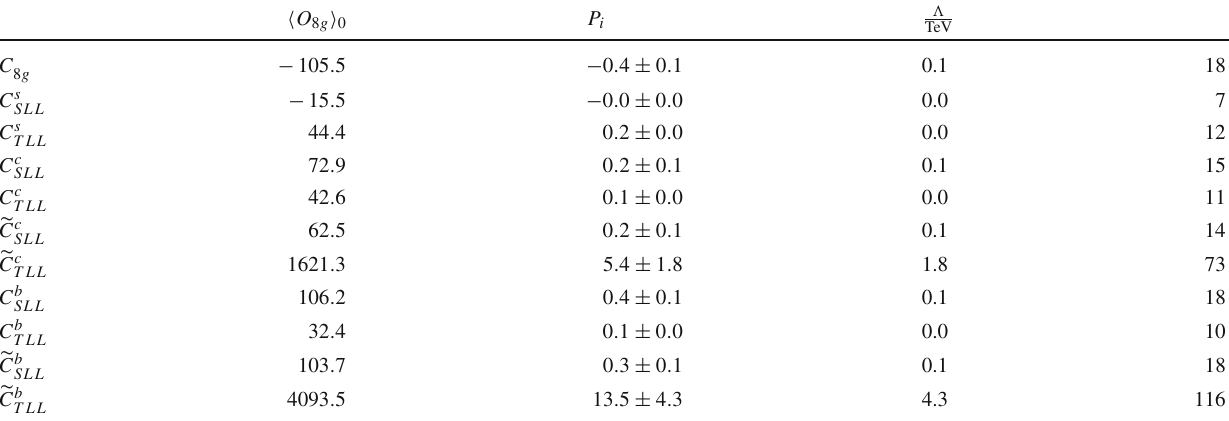
Table 7 Coefficients p ( I ) and P i of the master formula (18)–(19) as well as suppression scale (cid:8) (last column) from Wilson coefficients of Class ij B only entering via RG mixing into the chromo-magnetic dipole operator